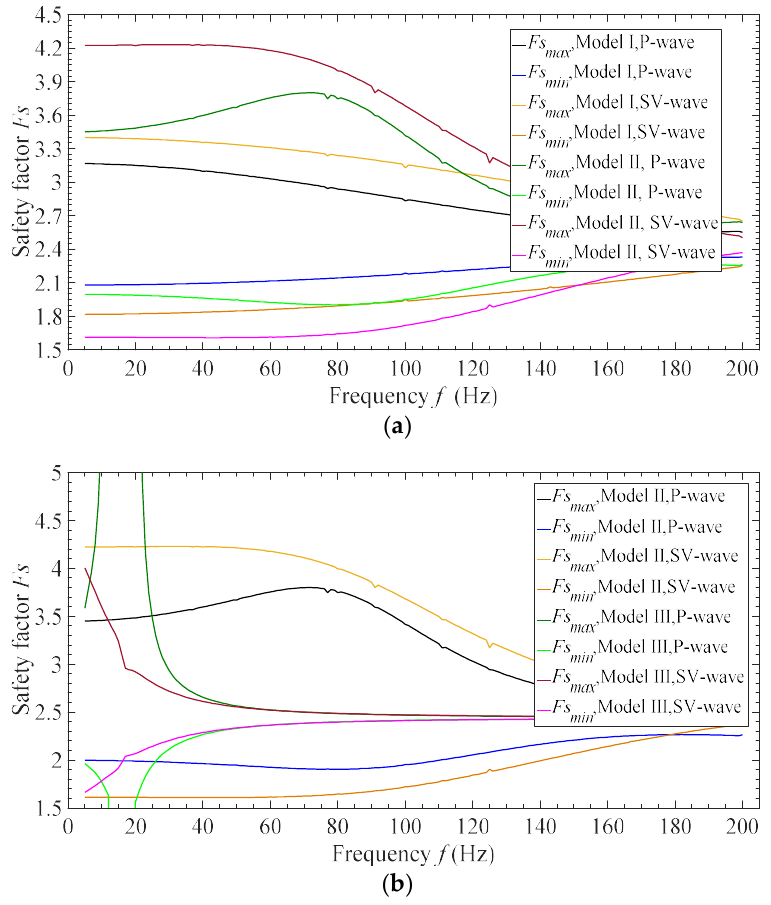
Figure 6. Instantaneous safety factor vs. wave frequency: ( a ) comparison between models I and II; ( b ) comparison between models II and III.